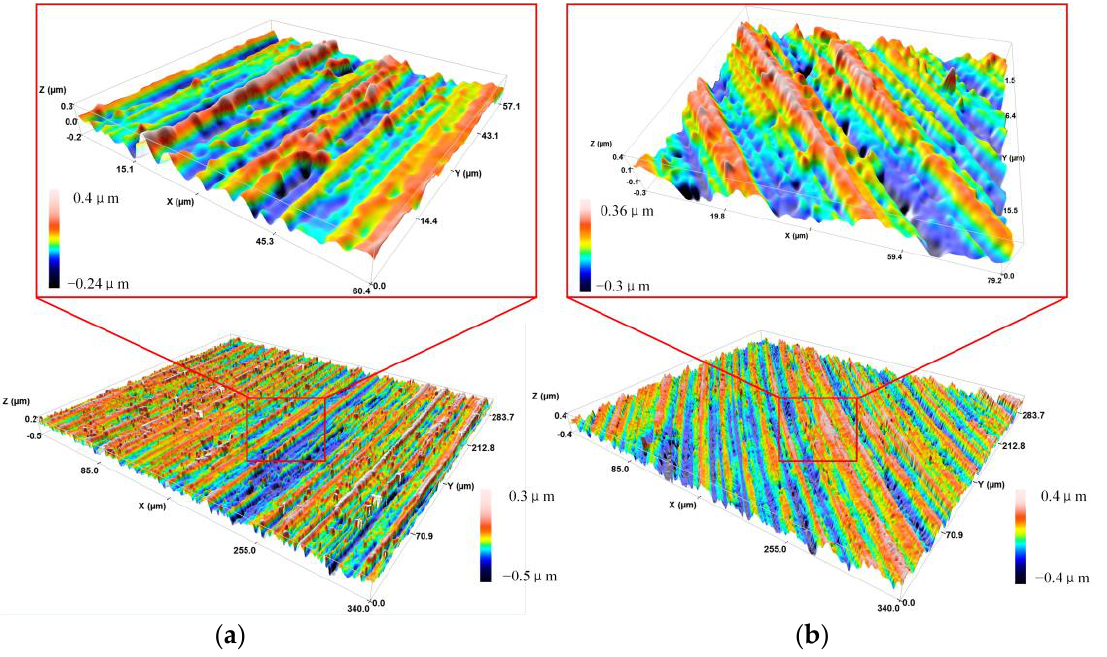
Figure 9. Three-dimensional surface morphology of UEVC workpiece. ( a ) The feed rate is 20 μm/r; ( b ) the feed rate is 25 μm/r.